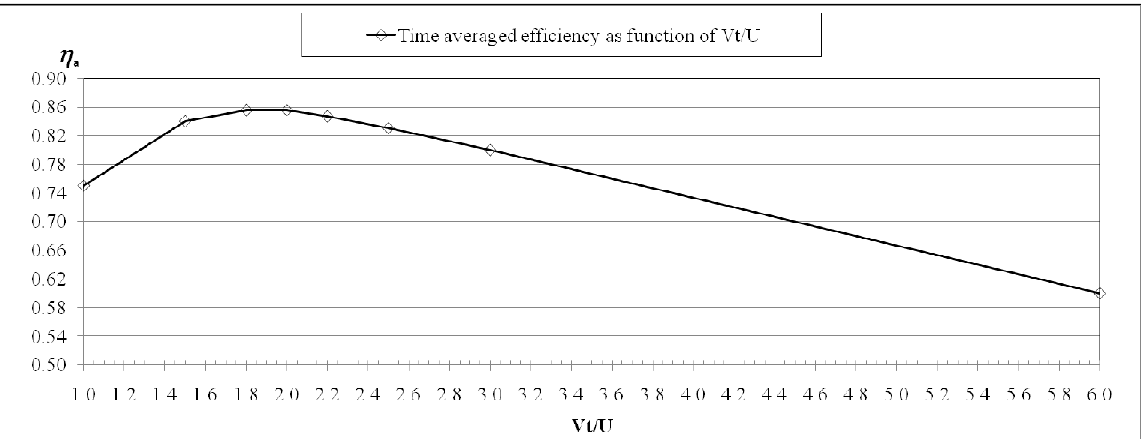
Figure 15. Efficiency curve of the designed turbine.